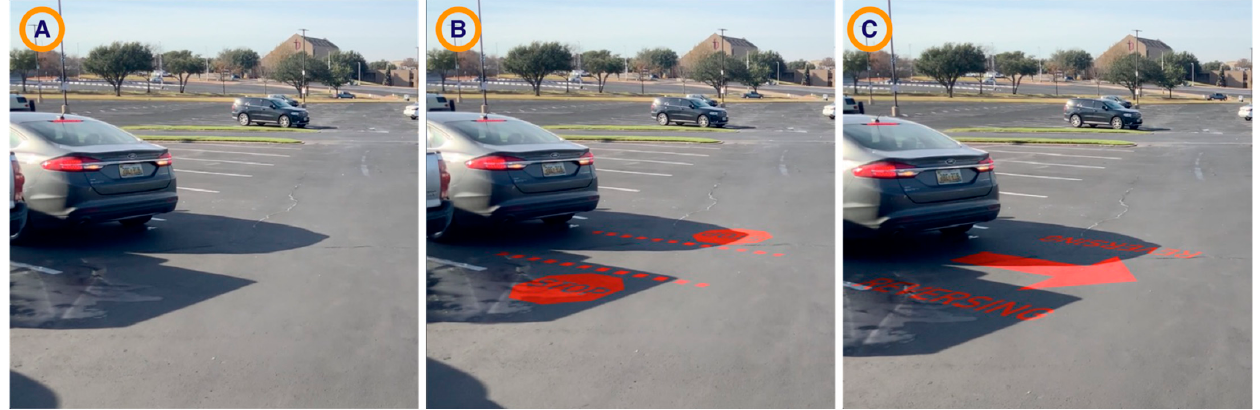
Figure 10. Projected messages in simulator video: ( A ) Brake Light Only, ( B ) Stop Signs (Pedestrian Instruction), ( C ) Reversing Arrows (Vehicle Intent).